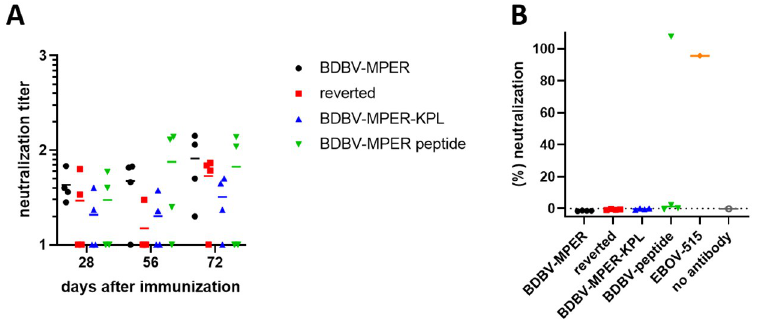
Fig 6. Neutralization studies from immunized rabbit sera. (A) Sera collected from individual immunized animals were tested for neutralization activity against BDBV, with no observable difference between the epitope carrying and non-carrying groups. (B) EBOV-515, a base-targeting antibody [8], neutralized chimeric infectious VSV/BDBV GP virus. Polyclonal antibodies from rabbits immunized on day 70 were not active, except for one sample from the BDBV- peptide immunization